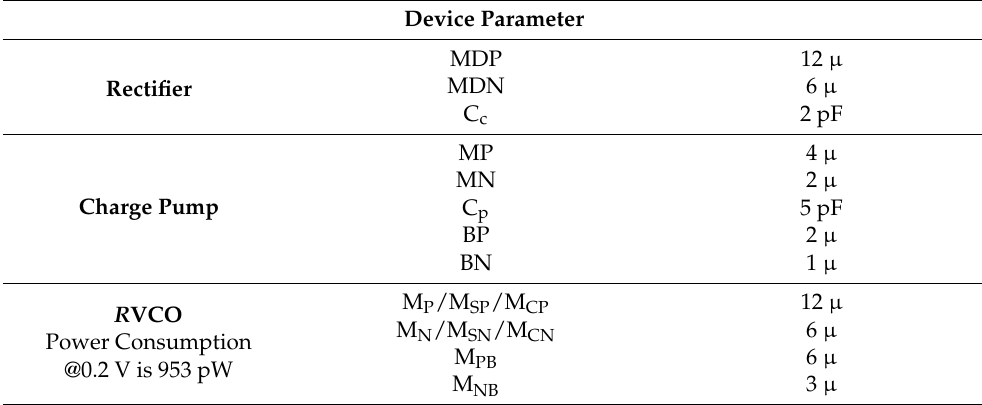
Figure 12. Chip Layout of the proposed RFEH System. Table 2. The transistor sizing of the proposed fully integrated RFEH system.